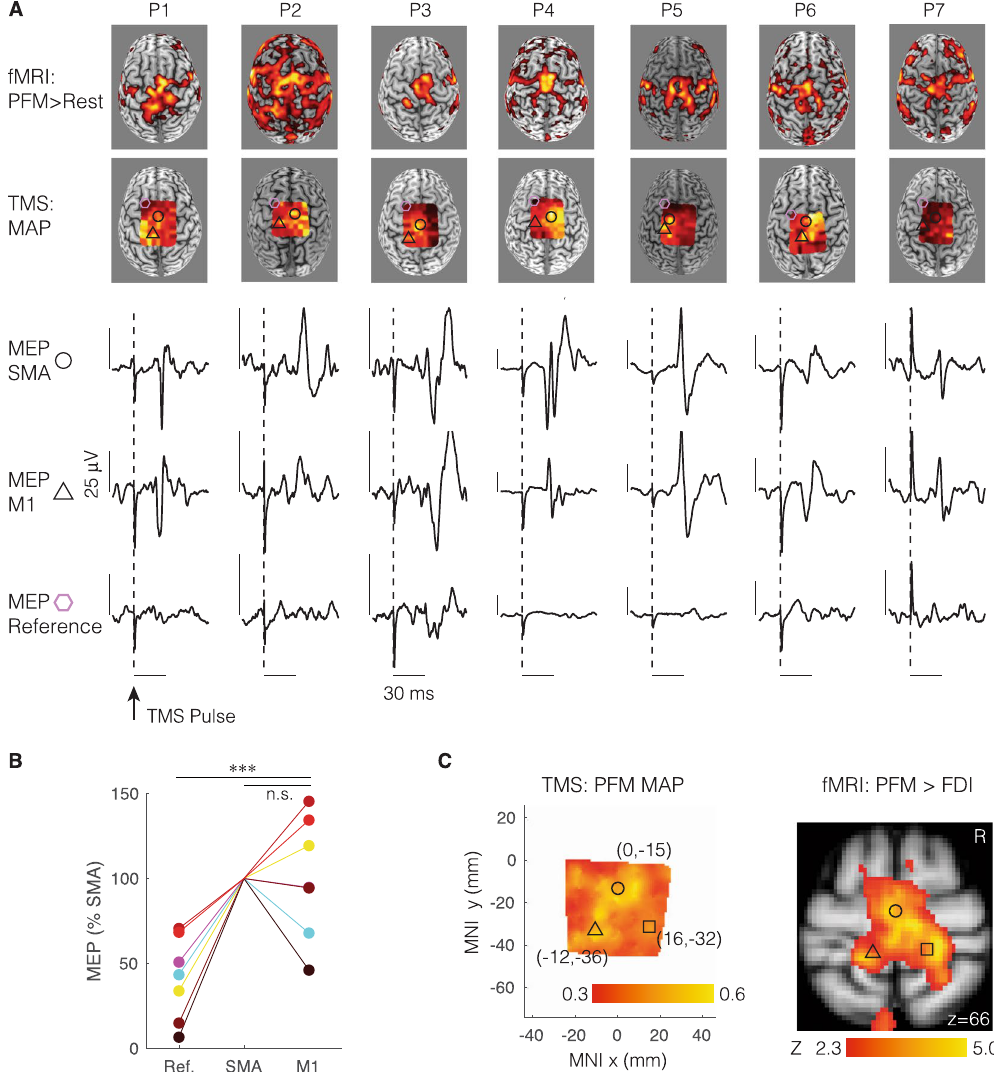
Figure 3. Transcranial magnetic stimulation (TMS) evidence of distributed motor cortical representation of human pelvic floor muscles (PFM). ( A ) Individual data from 7 participants who had both functional magnetic resonance (fMRI) and TMS testing. First row of images shows fMRI activation maps for the contrast PFM greater than rest (Z > 2.3, p < 0.05, corrected). Notice the distributed activation extending posterior and lateral to medial supplementary motor area (SMA), consistent with primary motor cortex (M1). Second row of images shows TMS maps of motor evoked potentials (MEPs) generated in the PFM during stimulation at rest. Notice again the MEPs did not appear confined to the medial wall and SMA. Shapes show locations chosen by the experimenter during the TMS session for further analysis: significant MEP and overlying SMA (circles), significant MEP and overlying left M1 (triangles), and a non-significant MEP reference site (hexagon). Subsequent rows show MEPs (averaged across 3 stimuli) evoked in the PFM from these locations in these participants. Notice that MEPs appeared in the PFM 21 milliseconds (ms) after the TMS pulse, consistent with direct (though not necessarily monosynaptic) connections, and that MEPs evoked from M1 were not generally smaller – and in some cases larger – than MEPs evoked from SMA. ( B ) Statistical analysis of MEP peak-to-peak size (normalized to SMA) revealed that PFM MEPs induced by stimulating M1 were significantly larger than PFM MEPs induced by stimulating the reference (p < 0.001), but were not significantly different from PFM MEPs induced by stimulating SMA (p > 0.05). ( C ) The TMS map for the PFM (averaged across participants) broadly mirrored the fMRI group activation map just under the scalp (z = 66 mm, MNI coordinates) for the contrast of PFM greater than first dorsal interosseous (FDI). Example coordinates chosen according to the Jülich anatomical atlas consistent with SMA (circle), left M1 (triangle) and right M1 (square) are shown for Methods Participant population. We performed three studies and recruited a total of 43 healthy participants with age (mean ± SD) of 30.0 ± 5.5 (range: 22–46 years). Participants included 25 women with age 29.2 ± 6.1 (range: 22–46 years) and 18 men with age 28.7 ± 4.6 (range: 24–43 years). There was no difference in age by sex